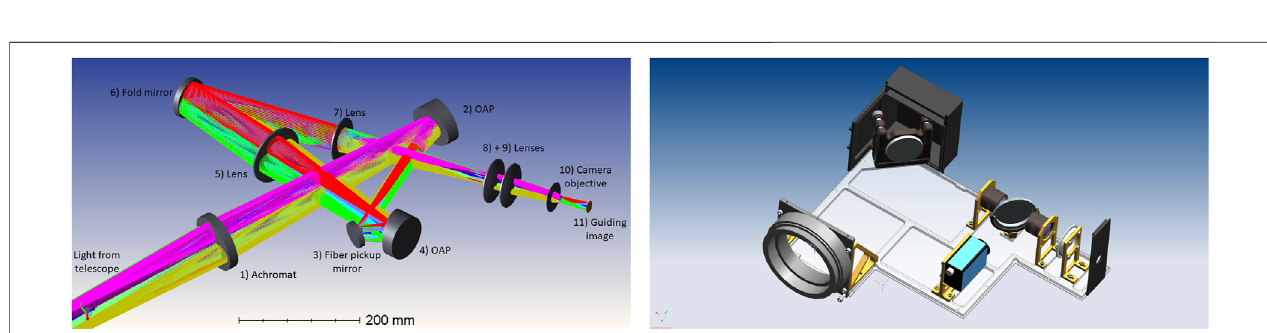
FIGURE 8 | Structure of a task in the LCO portal. While the green fi elds can occur only once, there can be multiple entries for the yellow fi elds (Request, Con fi guration, Window, InstrumentCon fi g).